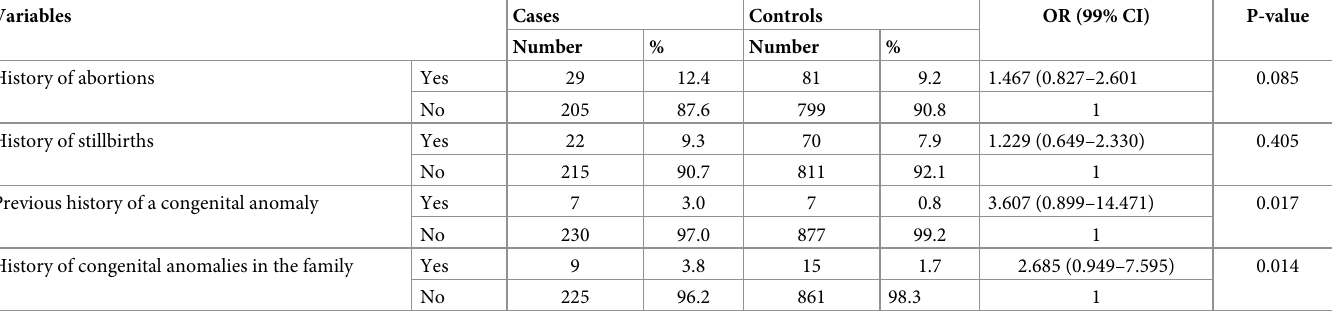
Table 4. Obstetrics history of the study subjects in southwestern